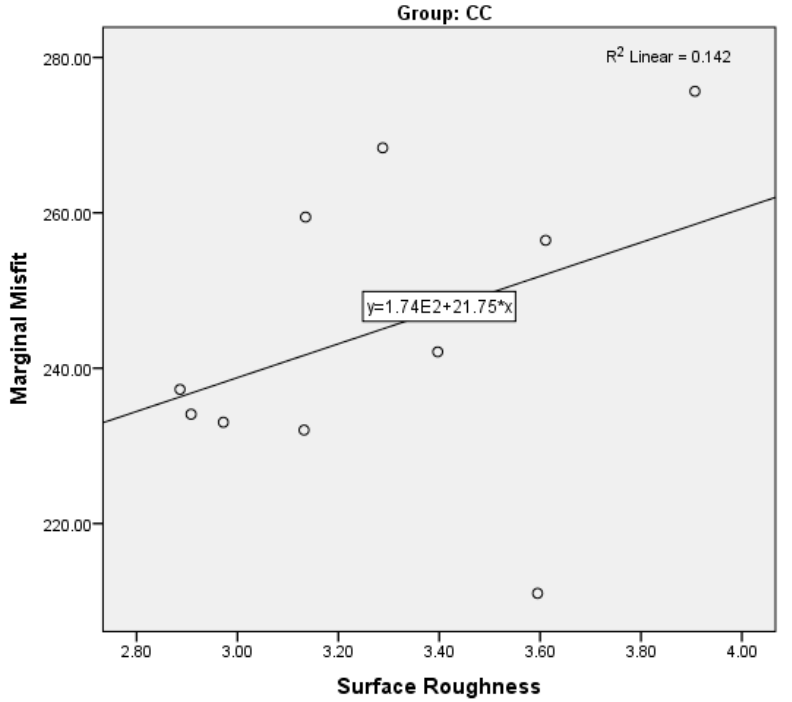
Figure 11. Scatter plot for the correlation between marginal misfit and surface roughness for the CC samples.